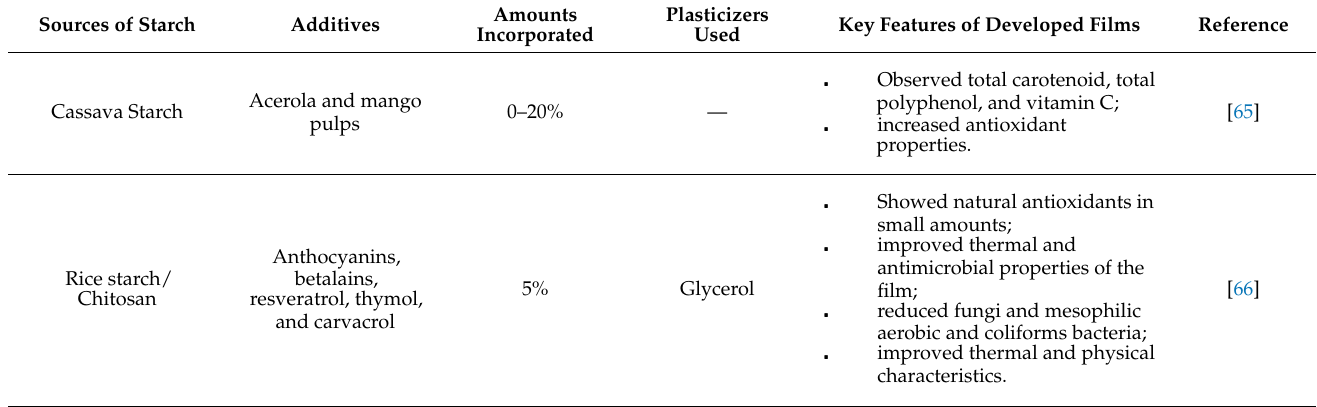
Table 3. Different pigments and other additives and their effects on starch-based